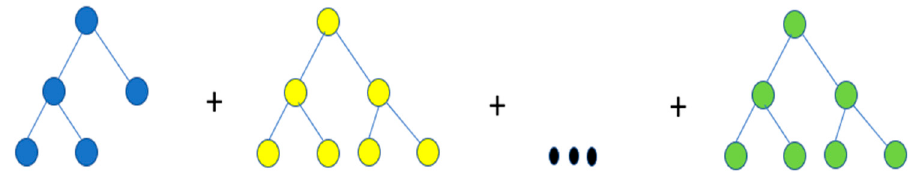
Figure 4. Iteration procedure of the GBR